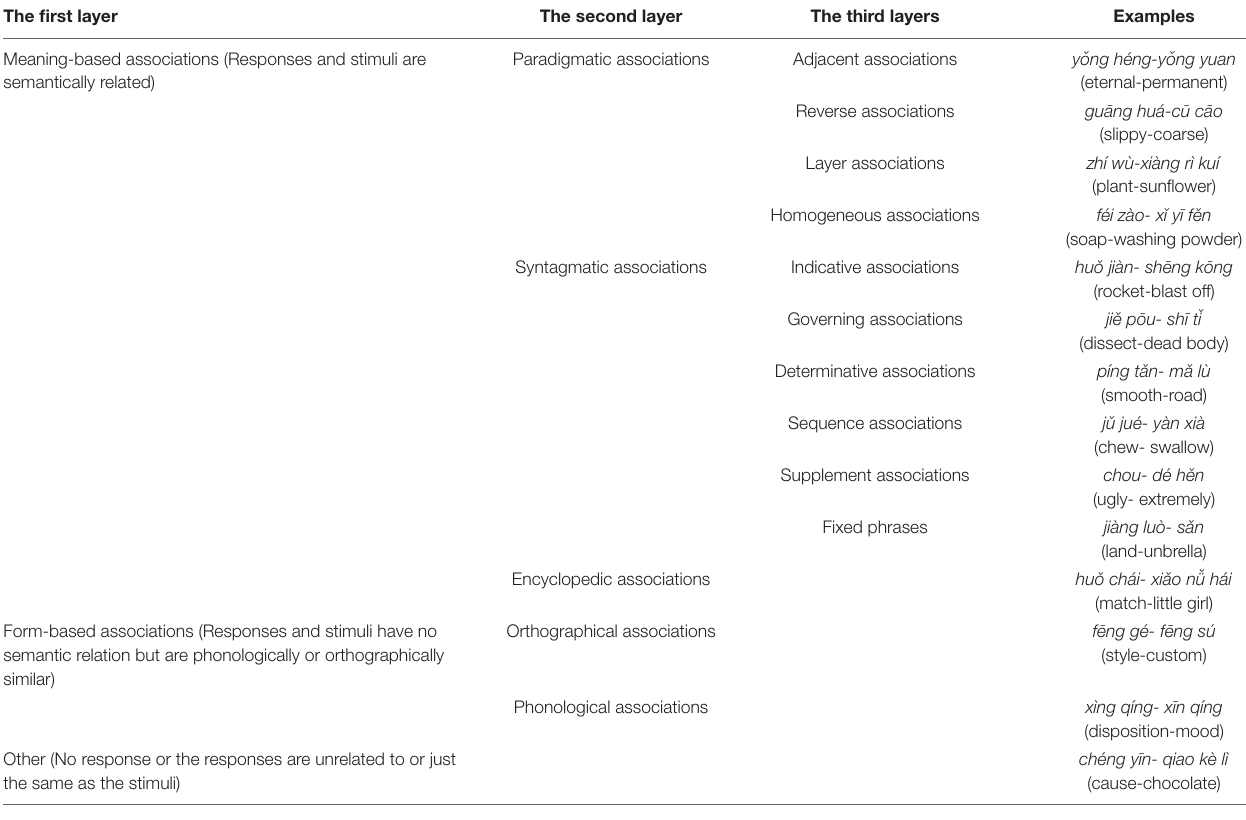
TABLE 2 | The classification framework of the associative responses of Chinese words. The first layer The second layer